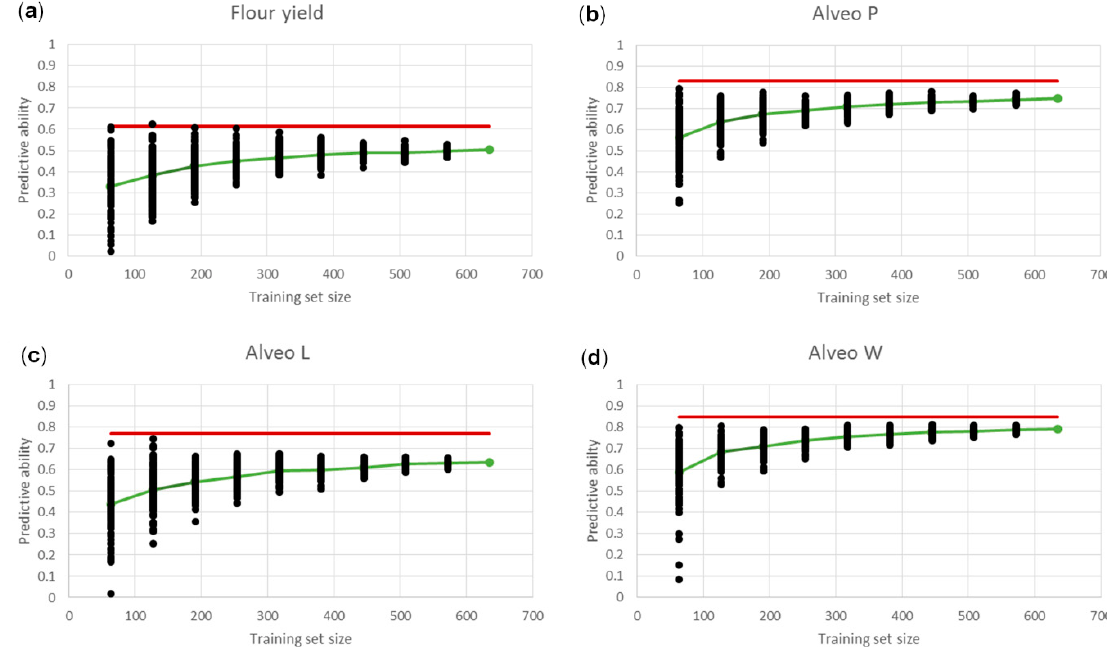
Figure 7. Predictive abilities based on leave-one-out cross-validations using reduced training set sizes. For each training set size, lines were selected randomly 100 times, and the average predictive abilities are shown with the green lines. The red lines are the square root of the narrow-sense genomic heritabilities based on all lines. ( a ): Flour yield, ( b ): Alveo P, ( c ): Alveo L, ( d ): Alveo W.